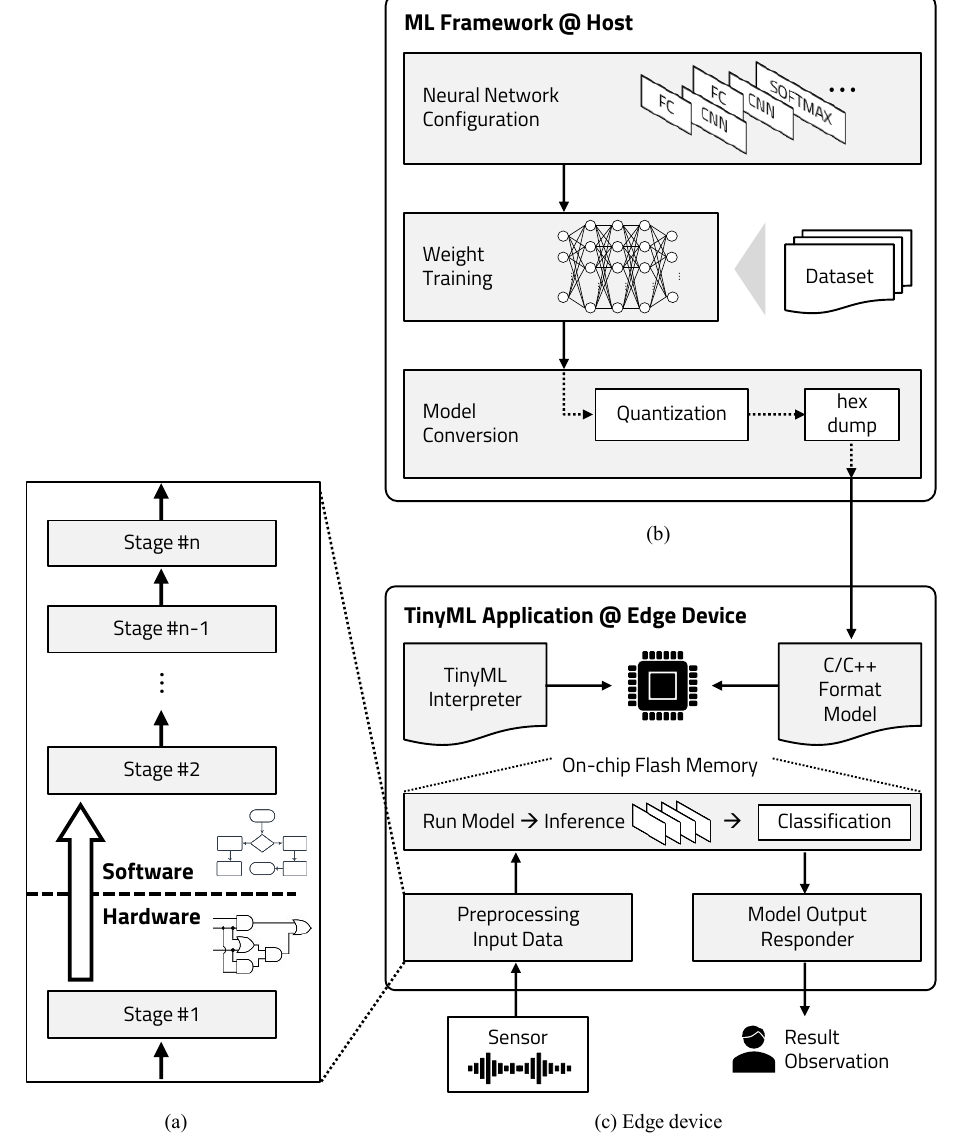
Figure 2. Overview of proposed TinyML application structure and design flow using machine learning (ML) framework at host. ( a ) hardware and Software partitioning at divided preprocessing stage ( b ) host machine ( c ) edge